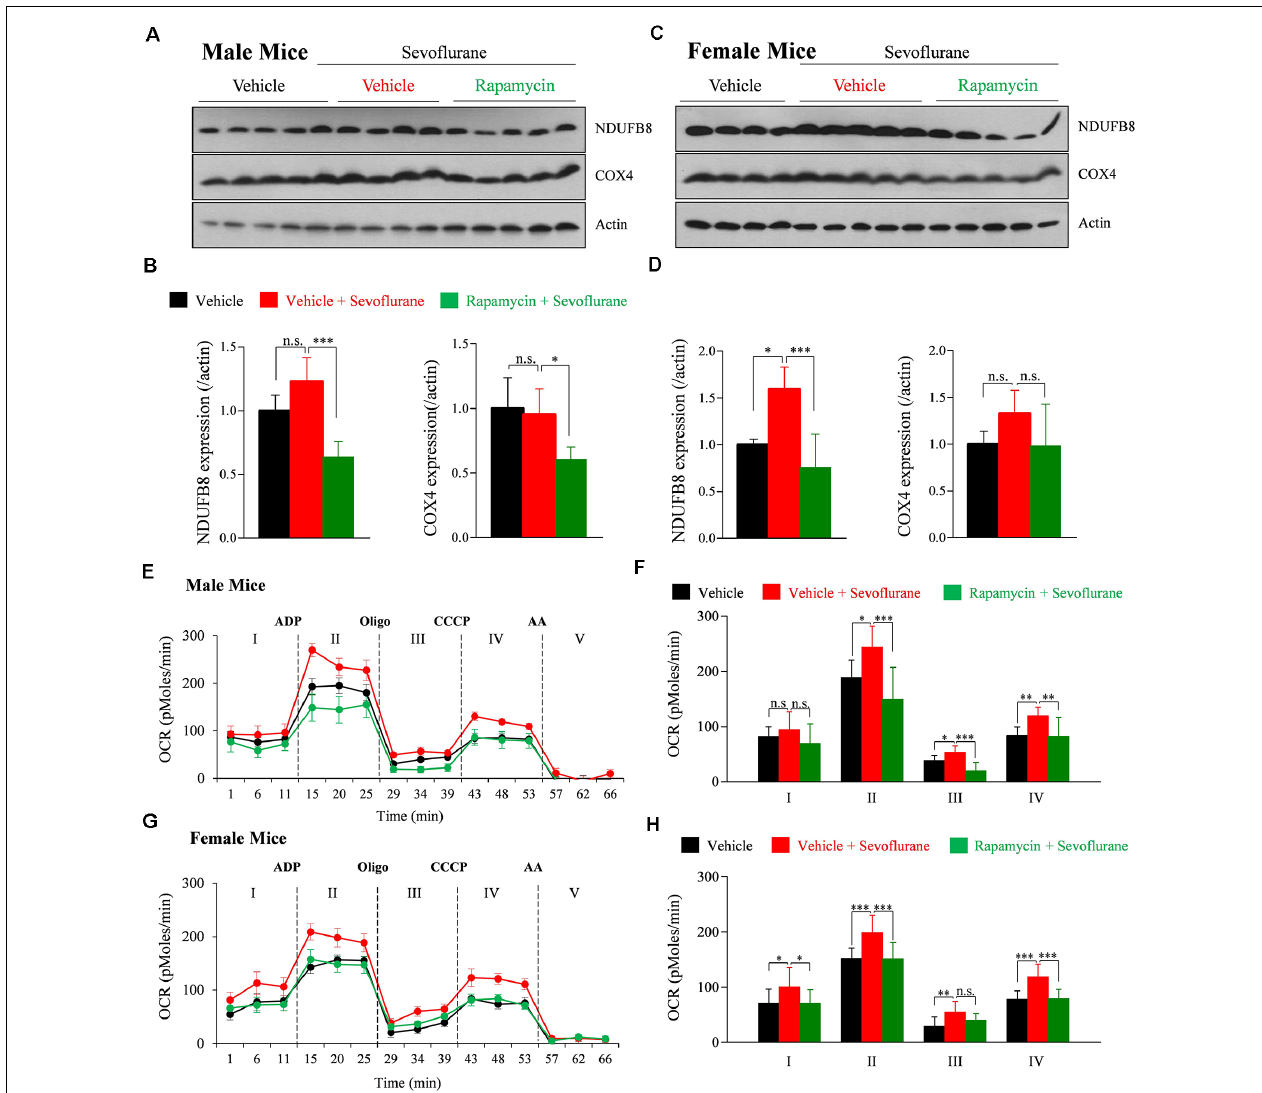
FIGURE 2 | Rapamycin prevents sevoflurane-induced increases in mitochondrial function and oxidative phosphorylation (OXPHOS) complexes in PND 16/17 mice. (A–D) Whole-brain samples obtained 24 h after sevoflurane exposure. (A,C) Western blotting with antibodies specific for the OXPHOS complex subunits NDUFB8 (OXPHOS complex I) and COX4 (OXPHOS complex IV) and actin (loading control) in male and female mice. (B,D) Quantification of mean ± SD protein band intensity in panels ( A,C ; n = 4 or 5 per group; n.s., not significant, ∗ p < 0.05, ∗∗∗ p < 0.01). (E–H) Oxygen consumption rate (OCR) of mitochondria isolated from the whole brain 24 h after sevoflurane exposure. The substrate was used by adding succinate to the mitochondrial assay buffer. Adenosine diphosphate (ADP) was used to stimulate adenosine triphosphate (ATP) turnover and ATP generation was measured with oligomycin (Oligo). Maximal OCR was assessed using carbonyl cyanide m-chlorophenyl hydrazone (CCCP) and non-mitochondrial OCR was measured using antimycin A (AA; n = 4 or 5 per group; n.s., not significant, ∗ p < 0.05, ∗∗ p < 0.01, ∗∗∗ p < 0.001). Values are presented as mean ±